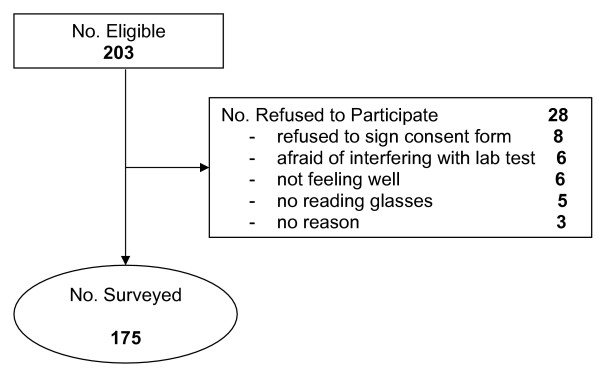
Participant recruitment procedure.